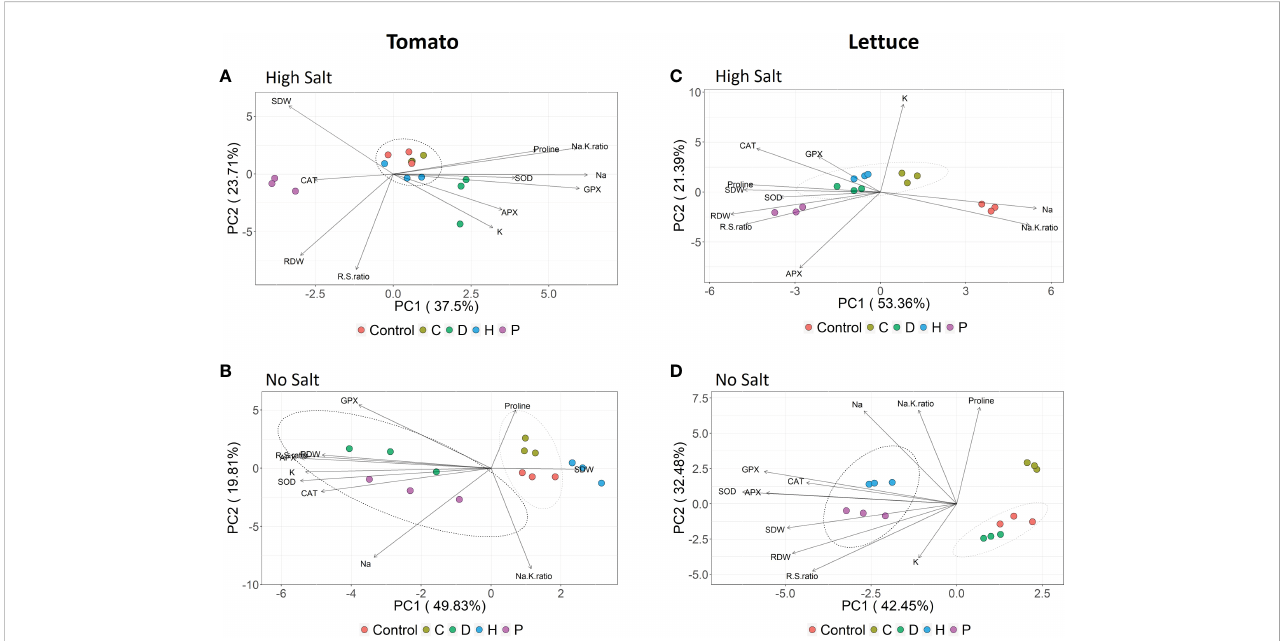
FIGURE 5 Principal component analysis (PCA) of major traits measured for tomato (A, B) and lettuce (C, D) summarizing the responses to vegetal-derived protein hydrolysates application (Control, C, D, H and P) under each salinity condition (no salt: 0 mM NaCl or high salt: 120 mM NaCl and 80 mM NaCl for tomato and lettuce,